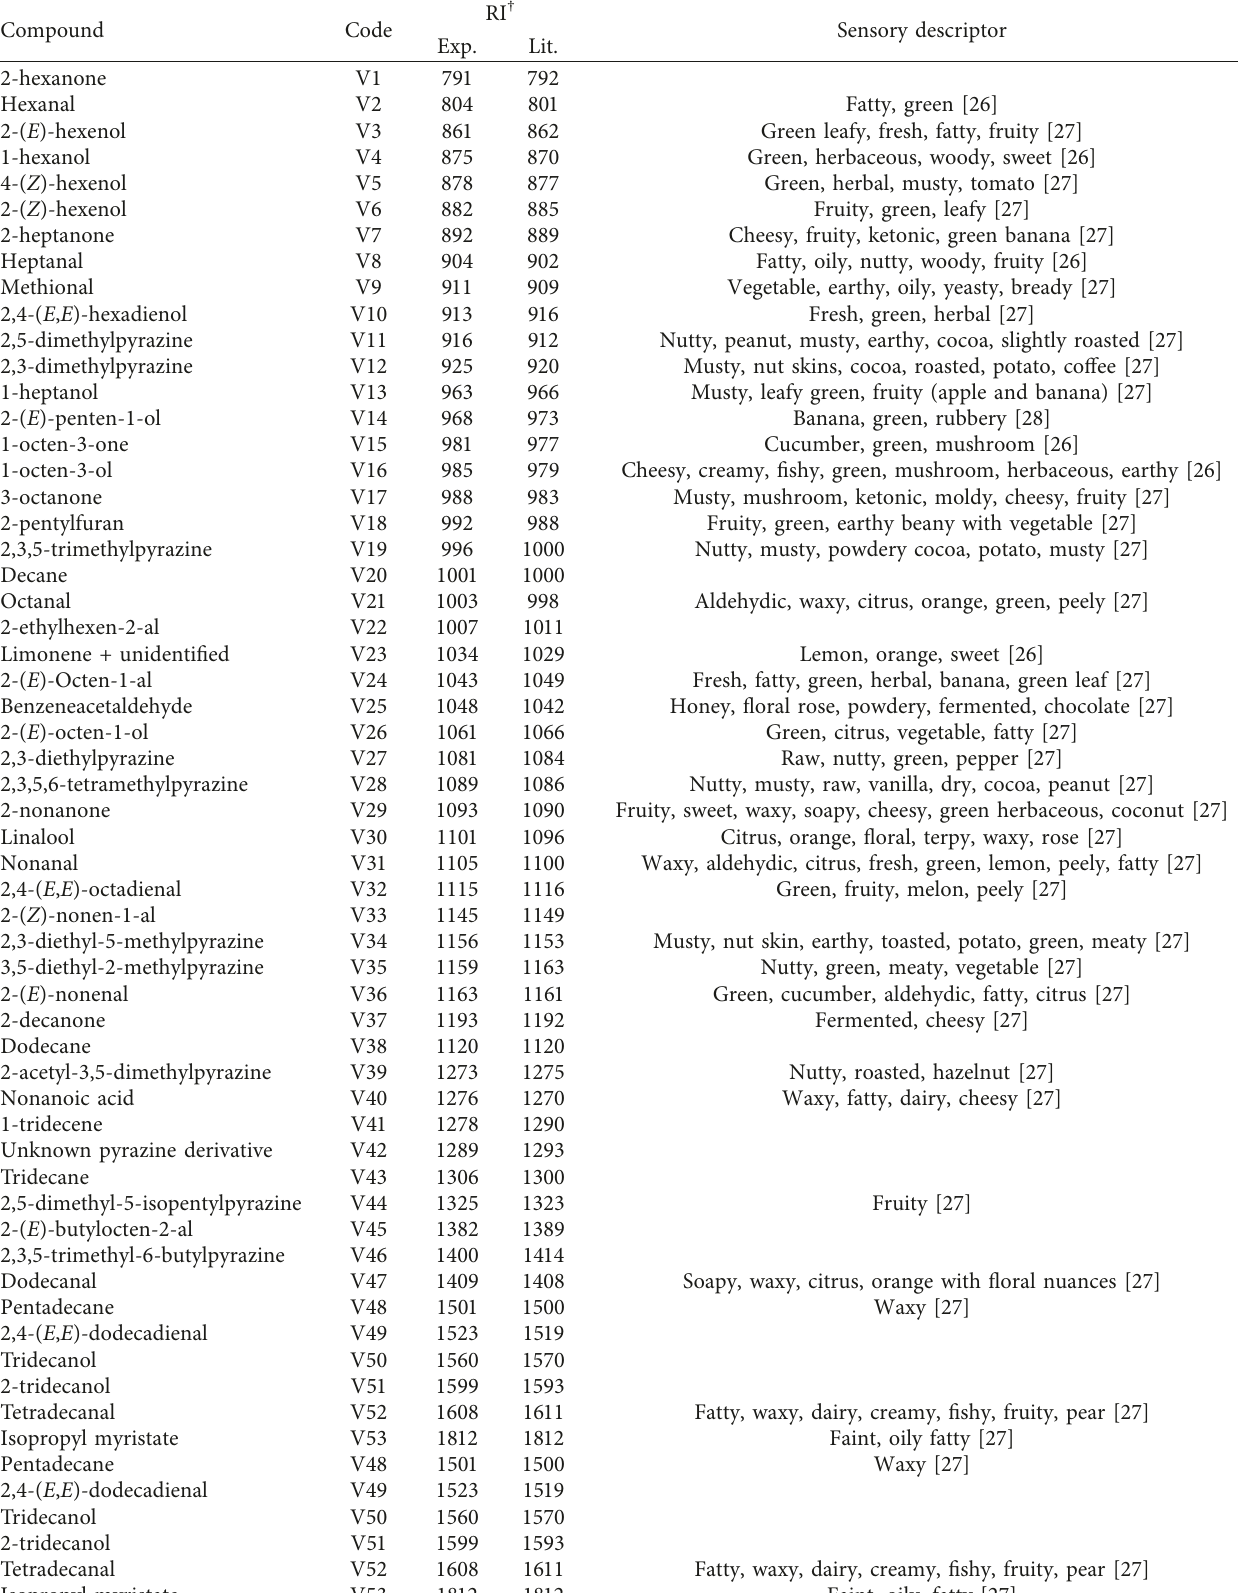
Table 2: Identification and codification of volatile compounds in fresh, freeze-, vacuum microwave-, and convective-dried cepe